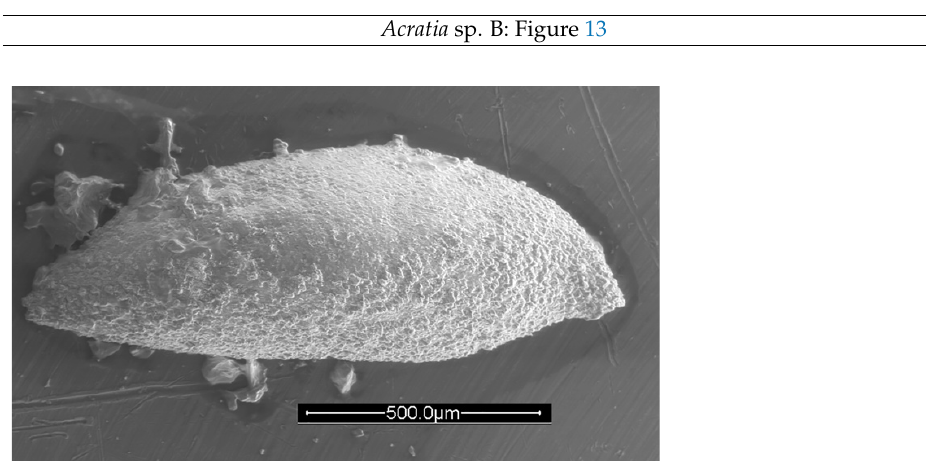
Figure 13. Acratia sp. B, right valve, lateral view. IGM 5011(9). Scanning electron micrograph (secondary electrons). Scale bar = 500 microns.